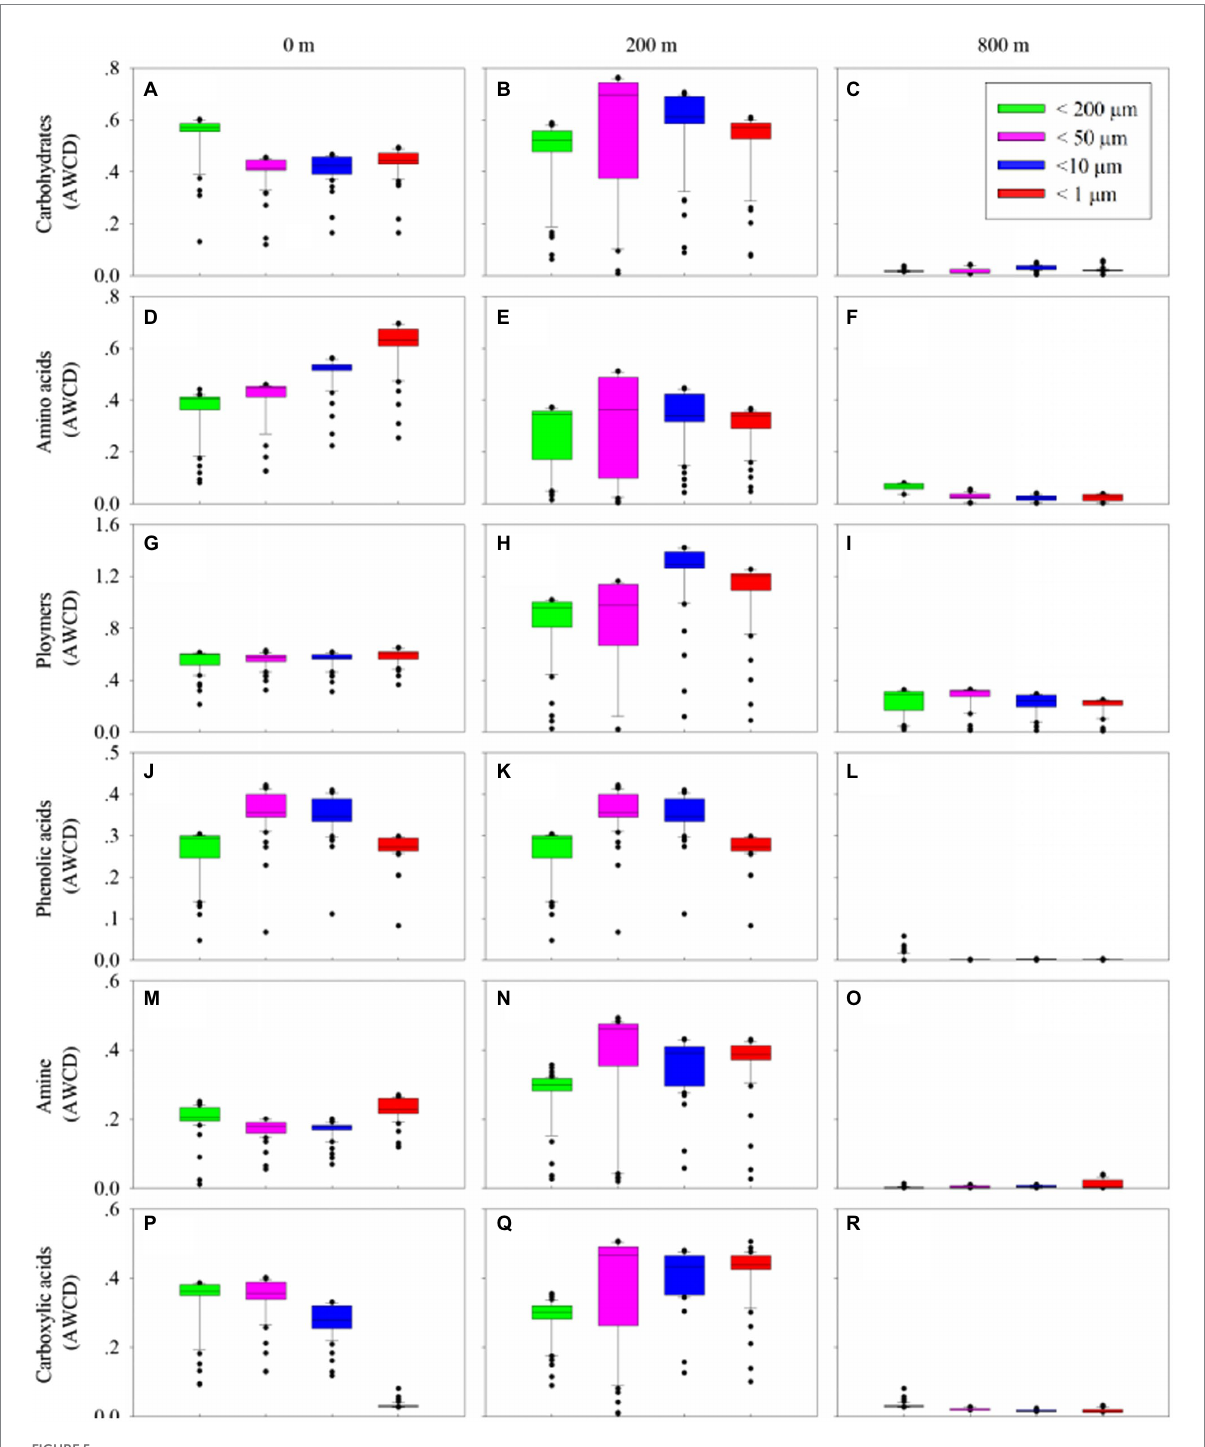
FIGURE 5 Box plots of utilization capability of the six major carbon groups, carbohydrates (A–C) , amino acids (D–F) , polymers (G–I) , phenolic acids (J–L) and amine (M–O) , carboxylic acids (P–R) , by microbes on different size-fraction particles at different water